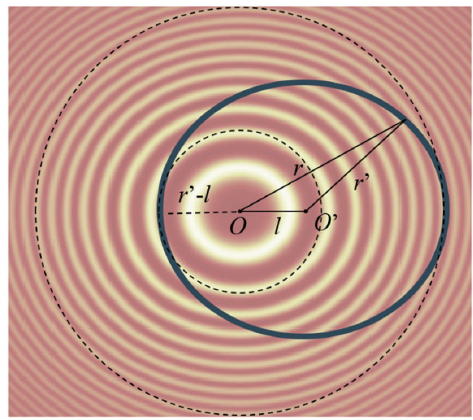
Figure 4. The analysis process of the MSDM.